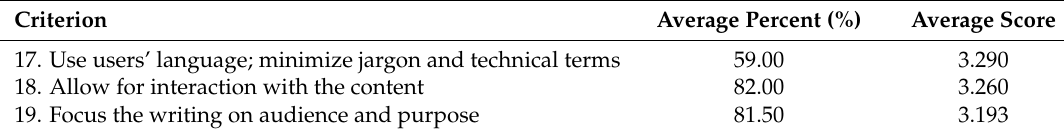
Table 6. Estimated percentages of websites in compliance with the criterion of content